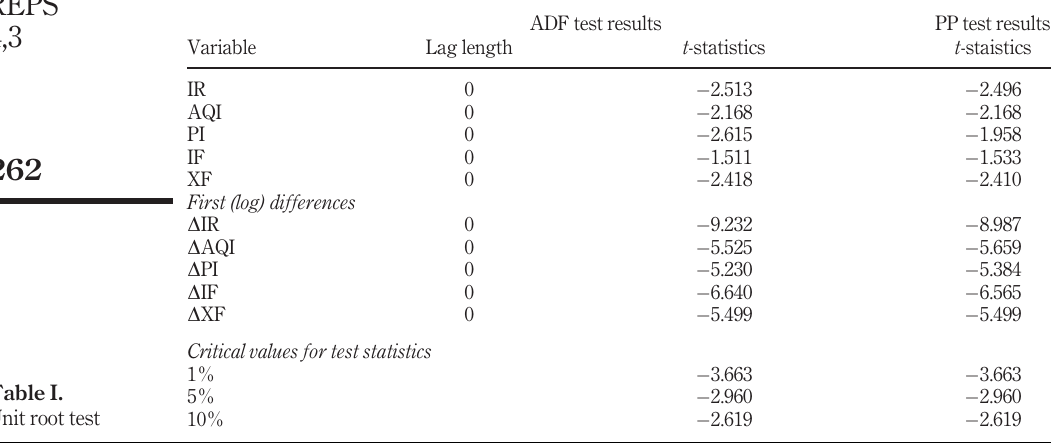
Table I. Unit root